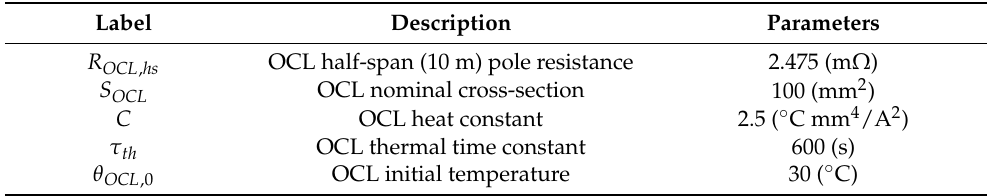
Table 2. Characteristics of the system conductors.